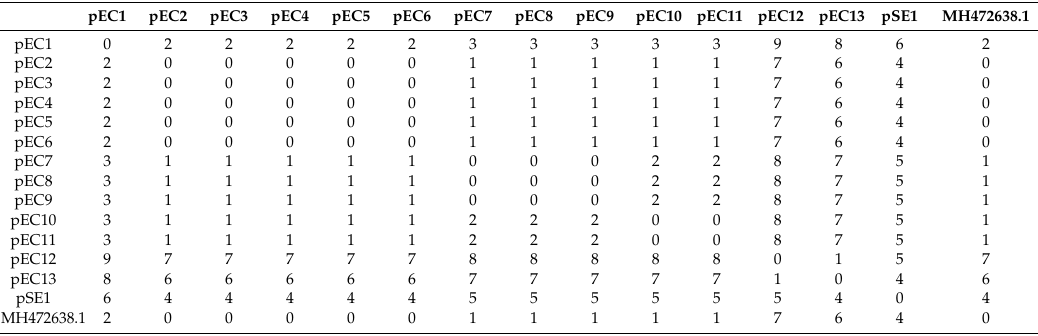
Table 2. Number of single nucleotide polymorphisms (SNPs) detected between the 14 extracted plasmids and GenBank reference plasmid MH472638.1.